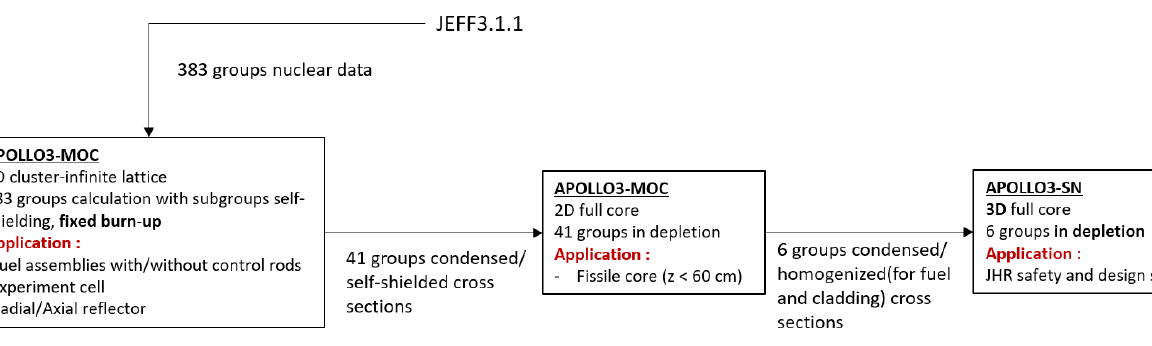
Figure 4. Description of the 3-step neutronic